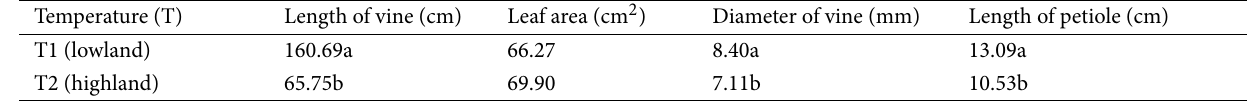
Table 2 Differences in sweet potato morphology caused by temperature at 13 weeks after planting.